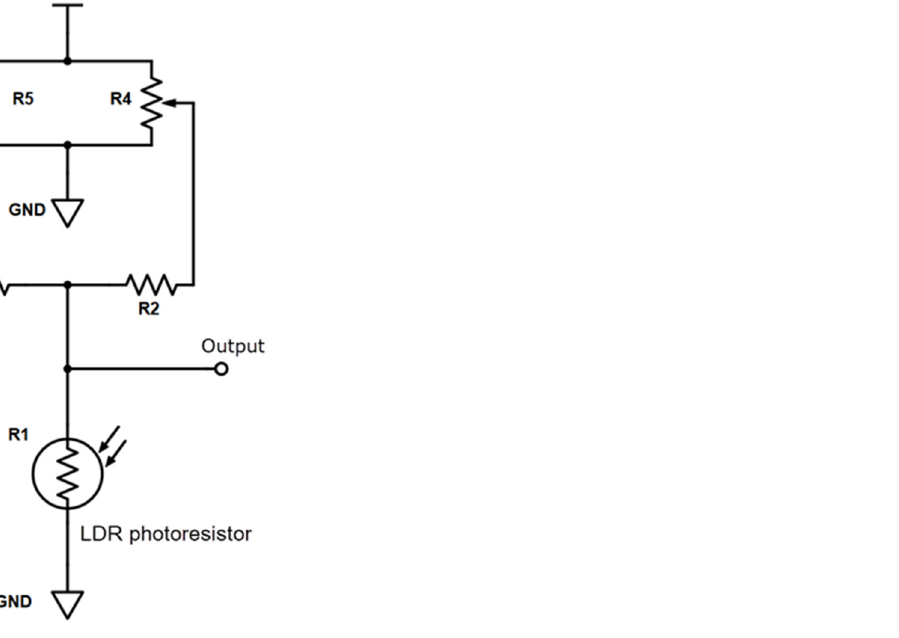
Figure 1. A schematic of the voltage divider LDR connection. R1: LDR (photo-resistor); R2: 100 k Ω , R3: 1 M Ω , R4 and R5: 10 k Ω multi-turn for the rough and fine-tuned voltage output adjustment,